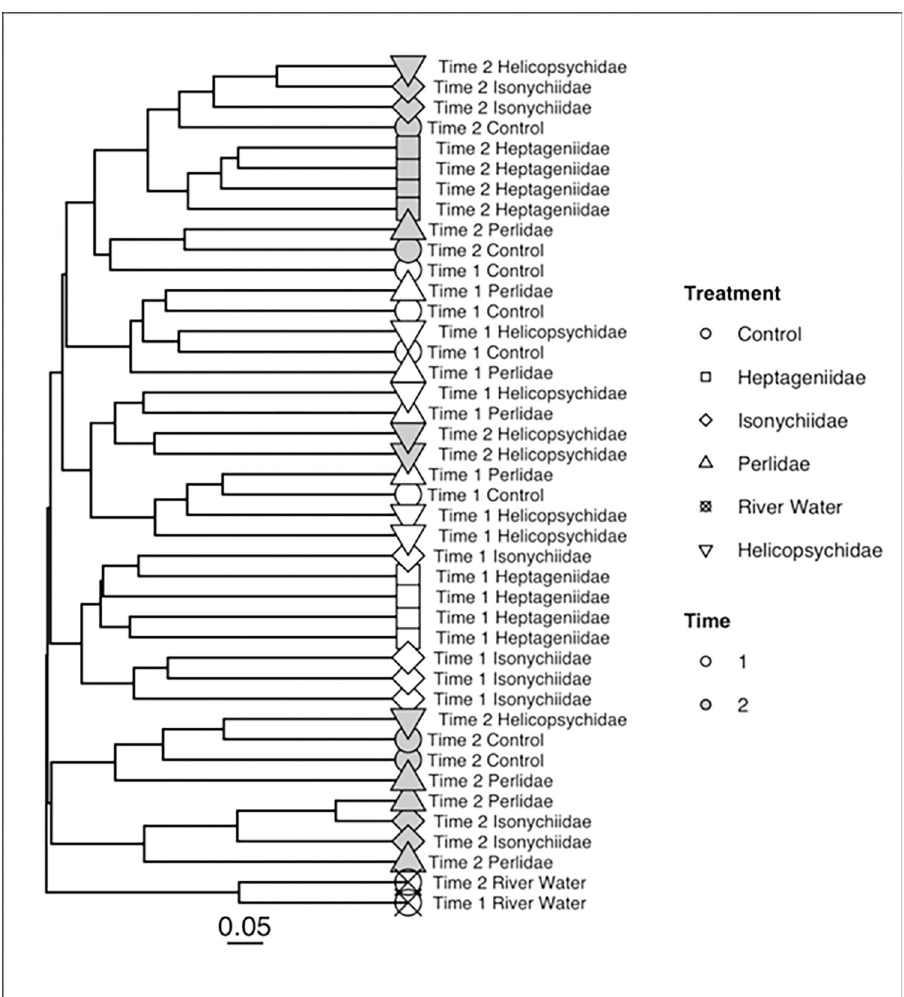
Fig 9. UPGMA diagram based on lower eukaryotic (18S) Bray-Curtis distances among lake sturgeon egg surface communities sampled at two time points for each of 4 aquatic insect treatments, a control (no insect) and stream water. Time 1 refers to collections 1 da post fertilization and Time 2 refers to 4 da post fertilization.